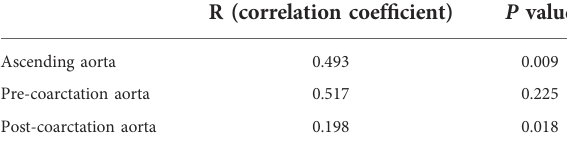
TABLE 4 Correlation of the z score of aorta and degree of